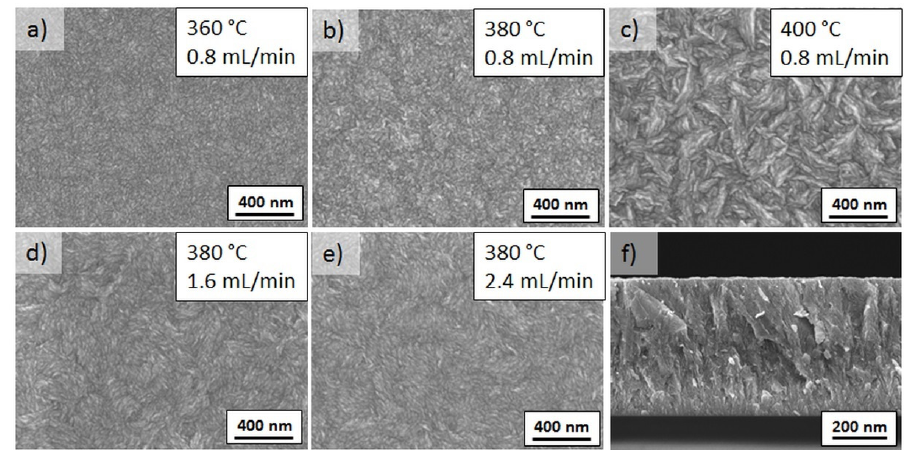
Figure 2. SEM plane views and cross section of ( a ) IZO-1; ( b ) IZO-2; ( c ) IZO-3; ( d ) IZO-4; ( e ) IZO-5; and ( f )